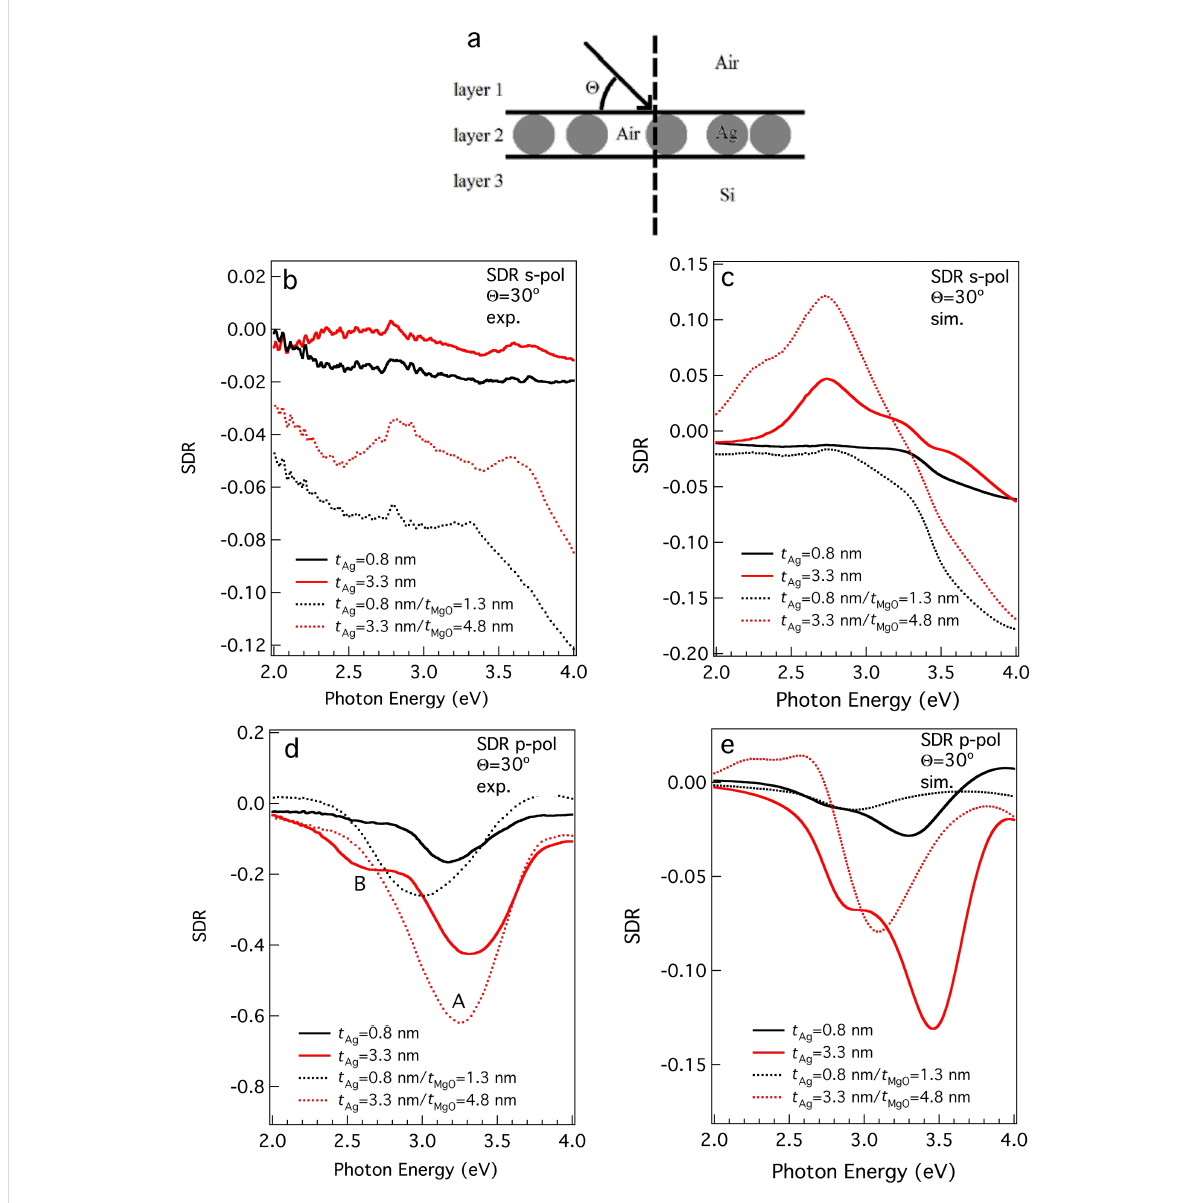
Figure 3: (a) Sketch of the geometry for the SDR experiments showing the incidence angle, Θ , and the system used for the simulation of the Ag NP films. (b) Experimental SDR spectra obtained under s-polarisation geometry from bare (continuous line) and MgO-covered (dotted line) Ag NPs deposited on Si/SiO x , with incidence angle Θ = 30°. (c) Simulated SDR spectra for s-polarised incident radiation with Θ = 30°. Results are shown for a nominal thickness of the NP layer t Ag = 0.8 nm (black curves) and t Ag = 3.3 nm. (d) Corresponding experimental SDR curves obtained under p-polarisation geometry. (e) Simulation results under p-polarisation illumination.